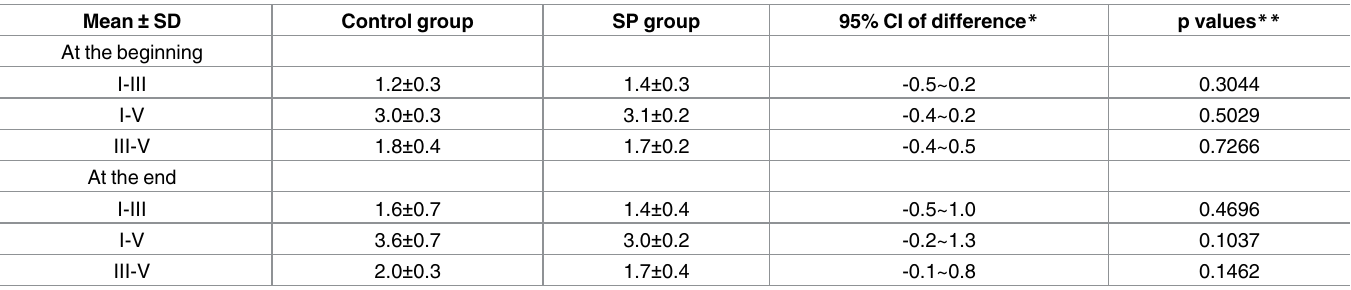
Table 2 shows the ABR intervals for both groups with click sound tests at the beginning and end of this study. We measured differences in ABRs between the control and SP groups and demonstrated that the I-III (1.2 ± 0.2 versus 1.2 ± 0.1 ms, respectively; P = 0.6150), I-V (3.2 ± 0.3 versus 3.2 ± 0.2 ms, respectively; P = 0.9732), and III-V (2.0 ± 0.3 versus 2.0 ± 0.2 ms, respectively; P = 0.7935) intervals with click sound stimulation were not significantly different at the beginning of this study. Further, as for differences between in the control and SP groups at the end of the study, the I-III (1.3 ± 0.1 versus 1.1 ± 0.3 ms, respectively; P = 0.2373), I-V (3.4 ± 0.5 versus 3.2 ± 0.2 ms, respectively; P = 0.4213), and III-V (2.1 ± 0.4 versus 2.1 ± 0.2 ms, respectively; P = 0.9273) intervals of ABRs with click sound stimulation were not significantly different. Table 3 shows the ABR intervals for both groups with 8-kHz tone burst sound at the begin- ning and end of this study. For the control and SP groups, the I-III (1.2 ± 0.3 versus 1.4 ± 0.3 ms, respectively; P = 0.3044), I-V (3.0 ± 0.3 versus 3.1 ± 0.2 ms, respectively; P = 0.5029), and burst stimulation were not significantly different at the beginning of this study. At the end of the study, the I-III (1.6 ± 0.7 versus 1.4 ± 0.4 ms, respectively; P = 0.4696), I-V (3.6 ± 0.7 versus 3.0 ± 0.2 ms, respectively; P = 0.1037), and III-V (2.0 ± 0.3 versus 1.7 ± 0.4 ms, respectively;